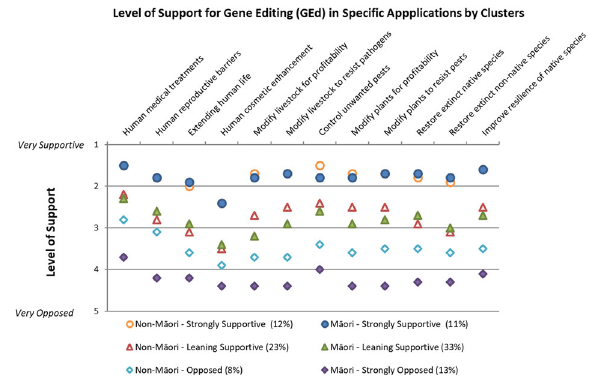
Fig. 4 Level of support for gene editing (GEd) in speci fi c applications by cluster types. Circles represent Strongly Supportive clusters; triangles represent Leaning Supportive clusters; and diamonds represent Opposed clusters. In each of the three perspectives, the opaque points are M ā ori clusters and the outlined points are non-M ā ori clusters. In the Strongly Supportive clusters, both M ā ori and non-M ā ori have similar supportive stances to the use of GEd in each of the applications. In the Leaning Supportive clusters, M ā ori and non-M ā ori have generally similar stances, although M ā ori are less supportive of several applications. In the Opposed clusters, M ā ori are much more opposed to all the GEd applications than non-M ā